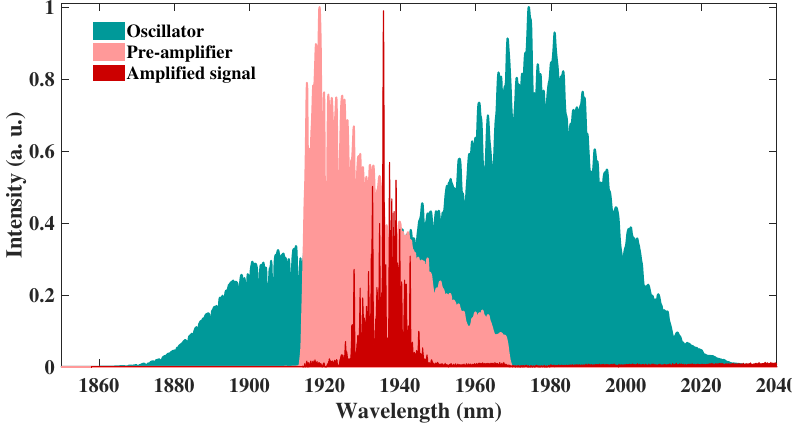
Figure 2. Recorded spectrum of the amplified pulses from the Tm:YAP regenerative amplifier using 23.5 W of absorbed power, operating under 10 kHz and − 20 ◦